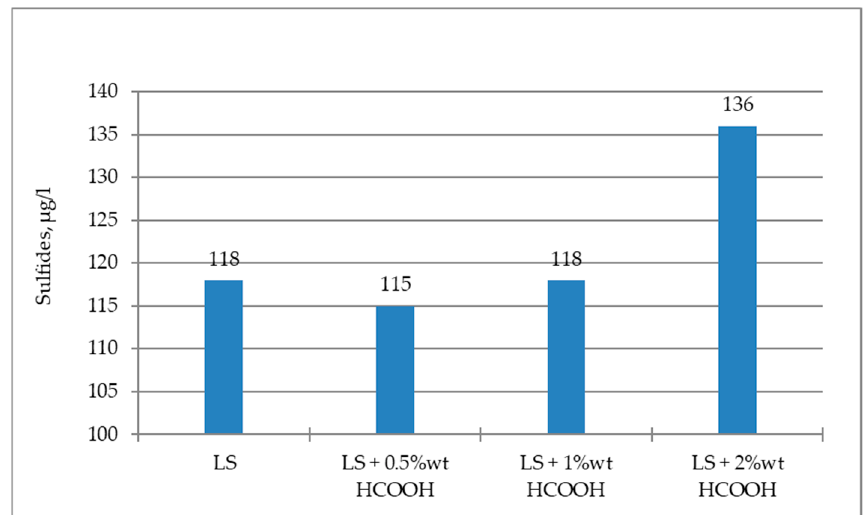
Figure 7. The pH in the washing bottle after flue gas cleaning.